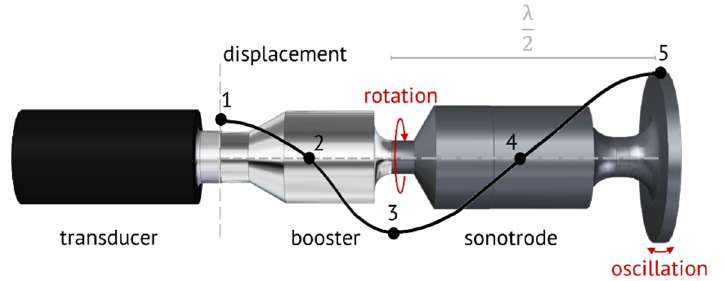
Figure 2. Structure and mechanical displacement along the rotatable oscillation unit of a continuous ultrasonic welding machine.